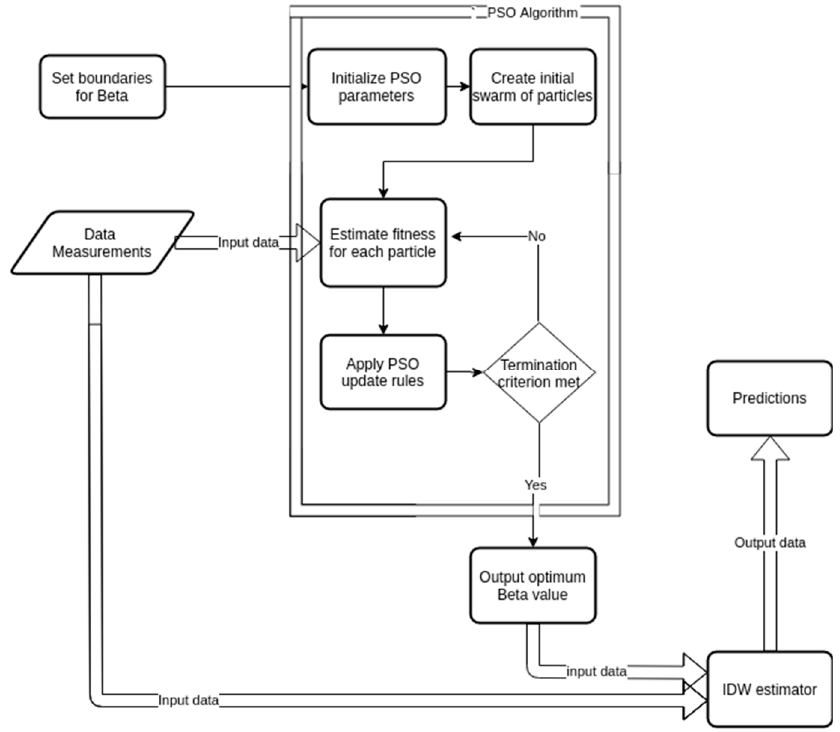
Figure 4. The flowchart of the Optimizing Inverse Distance Weighting (OIDW) algorithm.